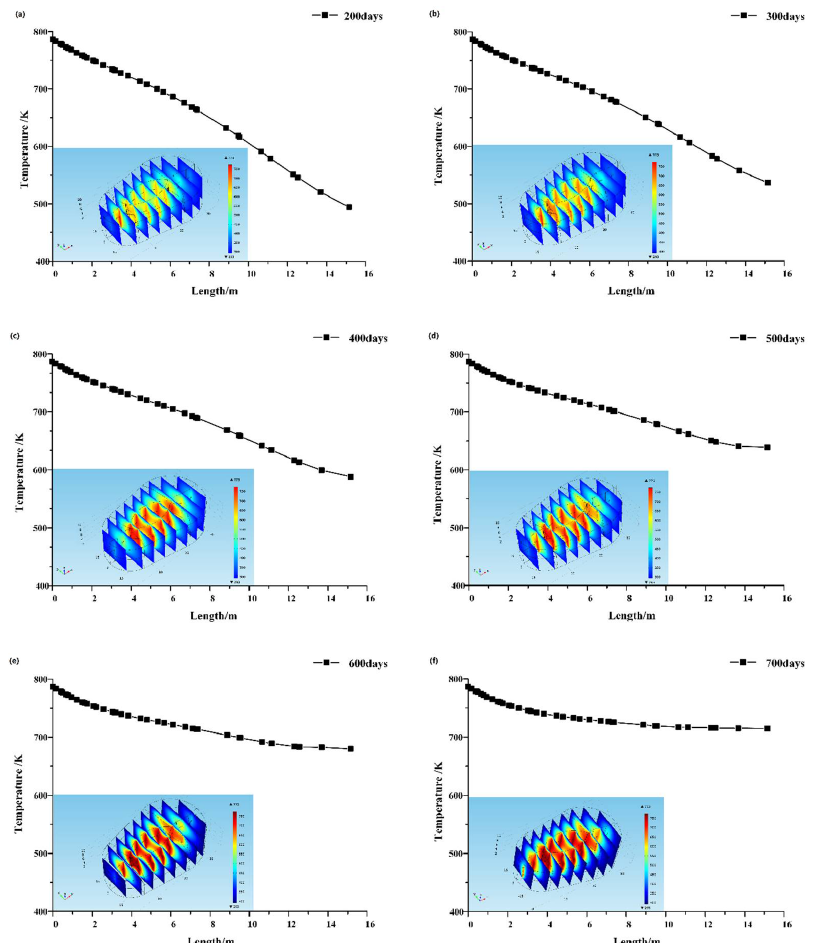
Figure 3. Oil shale reservoir temperature distribution under a gas injection rate of 11 m 3 /min. ( a ) Heating for 200 days; ( b ) Heating for 300 days; ( c ) Heating for 400 days; ( d ) Heating for 500 days; ( e ) Heating for 600 days; ( f ) Heating for 700 days.